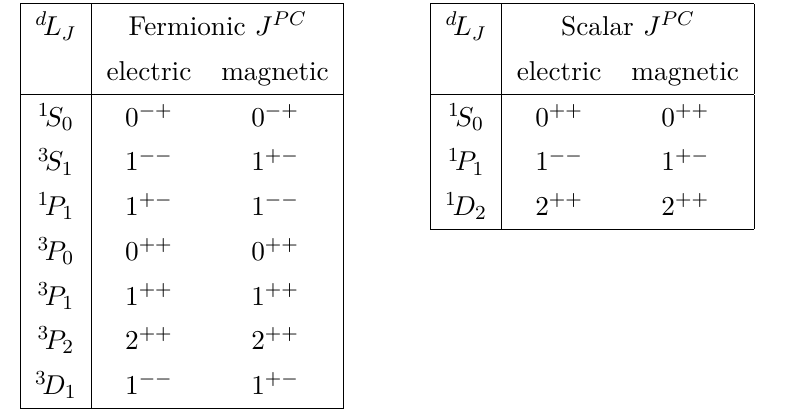
Table 2 . J PC quantum numbers for bound states of electric or magnetic particles with bound state spin degeneracy d , orbital angular momentum state L , and total angular momentum J . Bound states composed of fermions (scalars) are on the left (right).